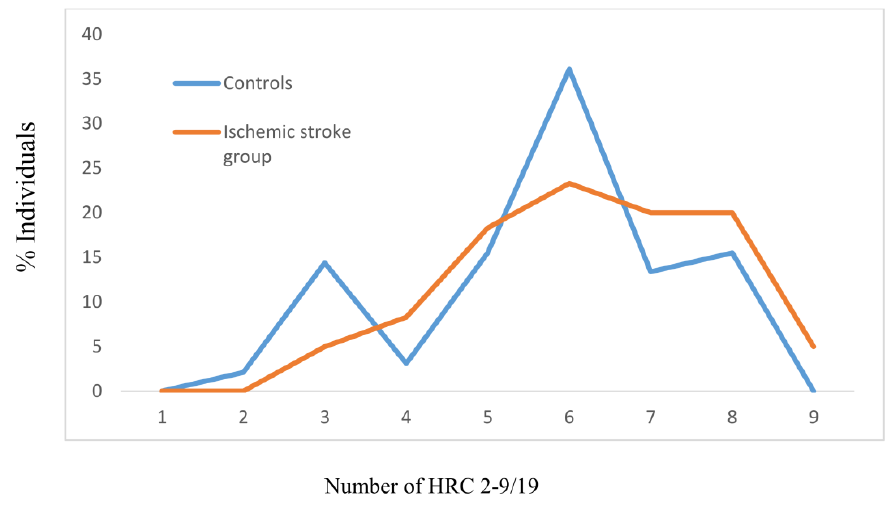
Figure 1. Frequencies of homozygous recessive characteristics (HRC) in controls and manifested ischemic stroke patients. MV- mean value; SD- standard deviation; z - Mann Whitney U test; V- variability. Controls: N = 194, MV ± SD = 5.71 ± 1.61. Ischemic stroke group: N = 120, MV ± SD = 6.25 ± 1.54 ( z = − 2.496, p = 0.012; Cohen’s d = 34.28%). V Controls = 28.20%, V Ischemic stroke group = 24.64%.